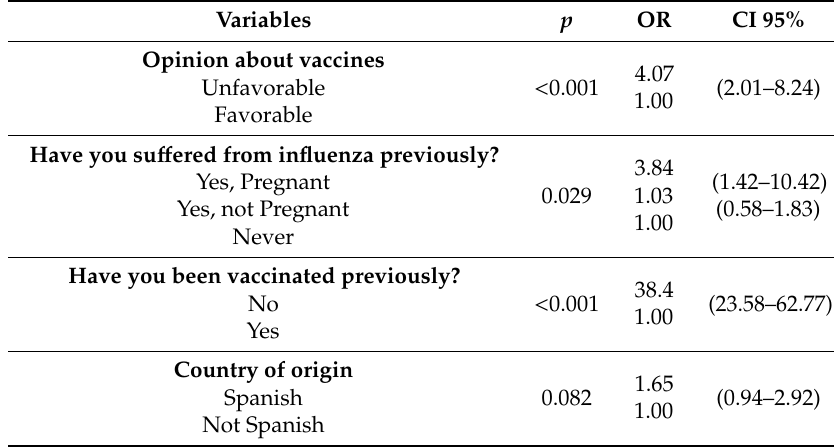
Table 3. Multivariate logistic regression analysis to estimate the association and predictive ability about the predisposition for the future intent of